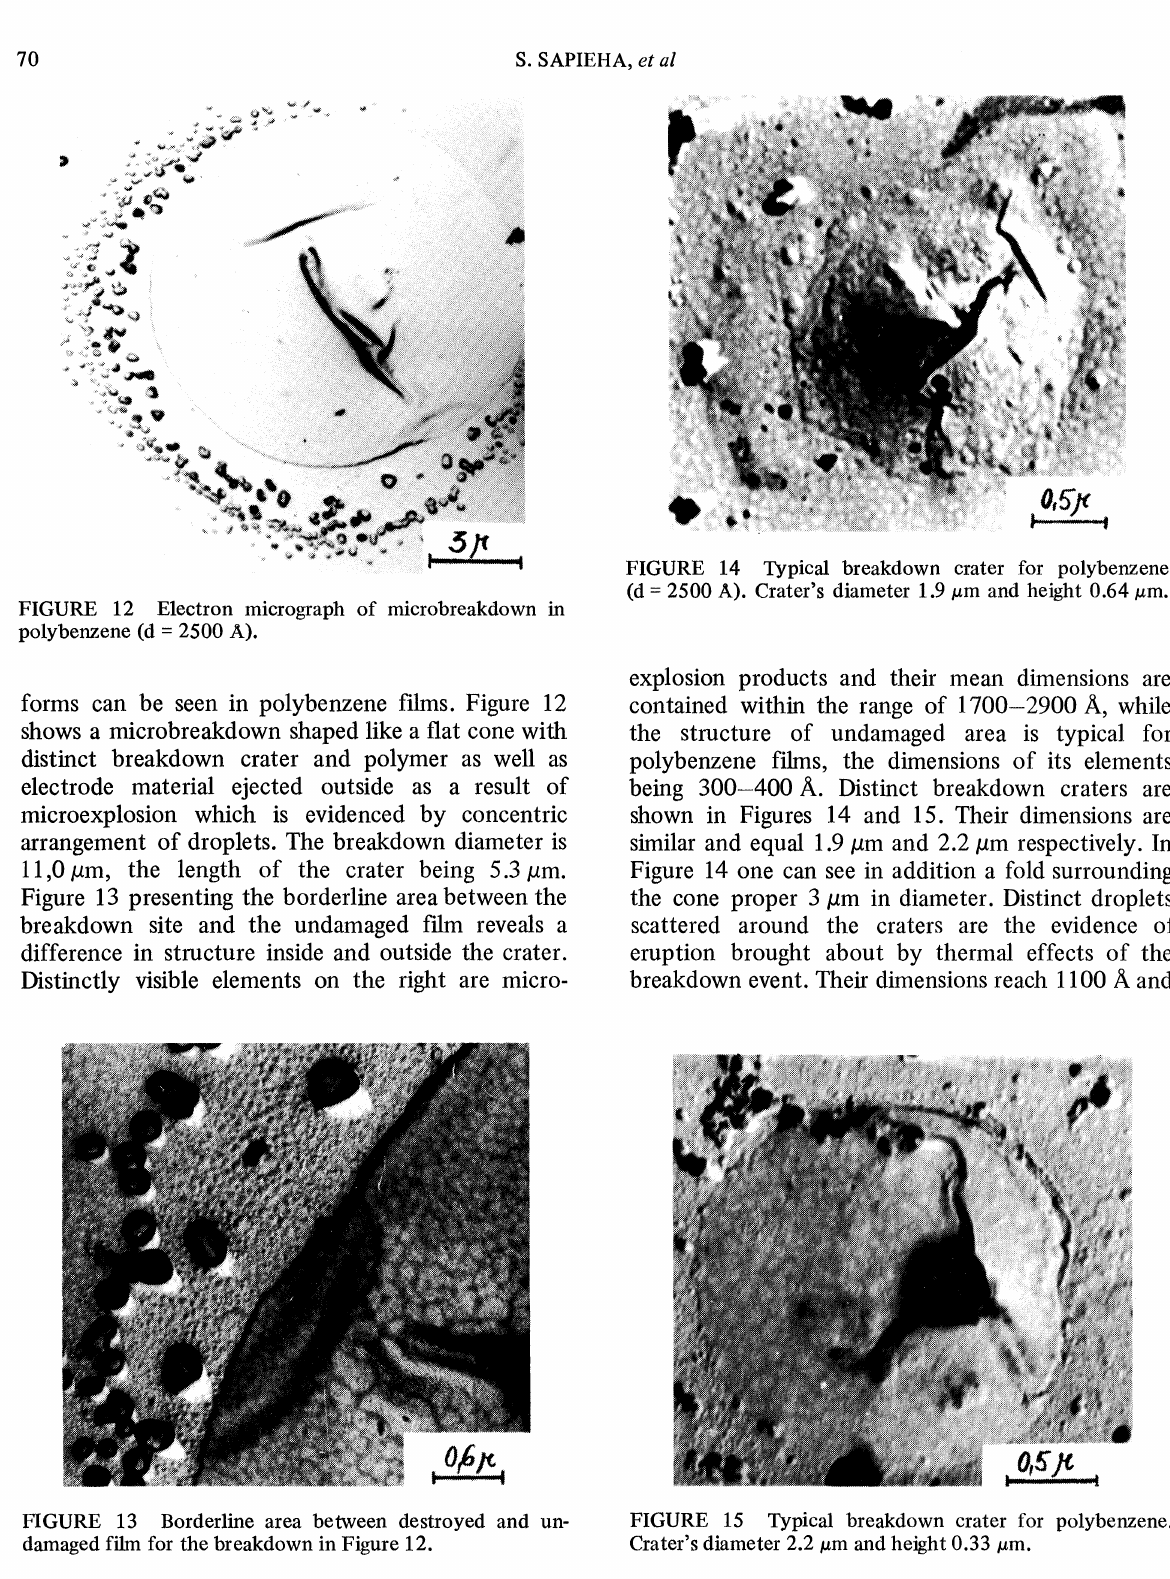
FIGURE 13 Borderline area between destroyed and un- damaged film for the breakdown in Figure 12.